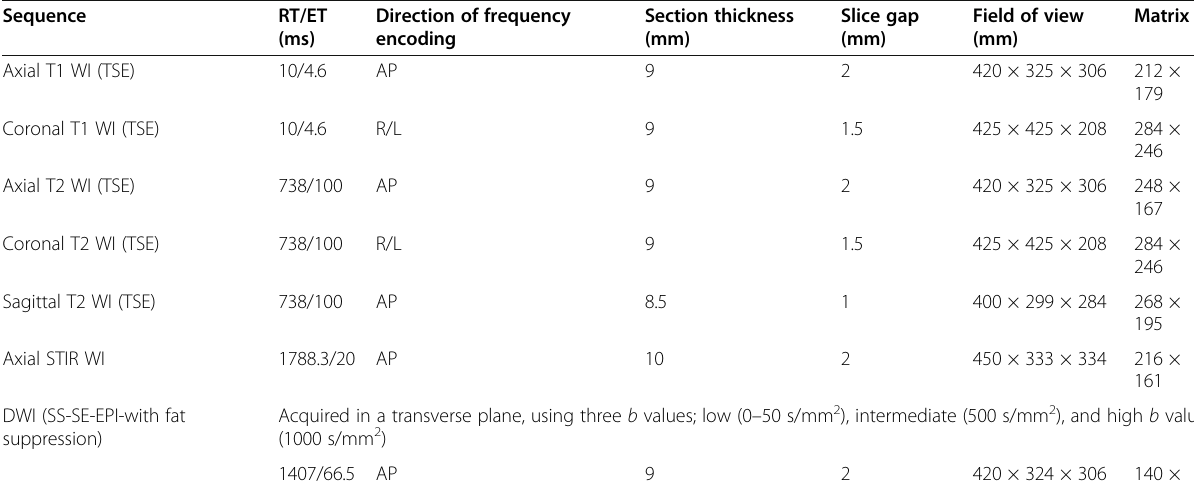
Table 2 MR imaging